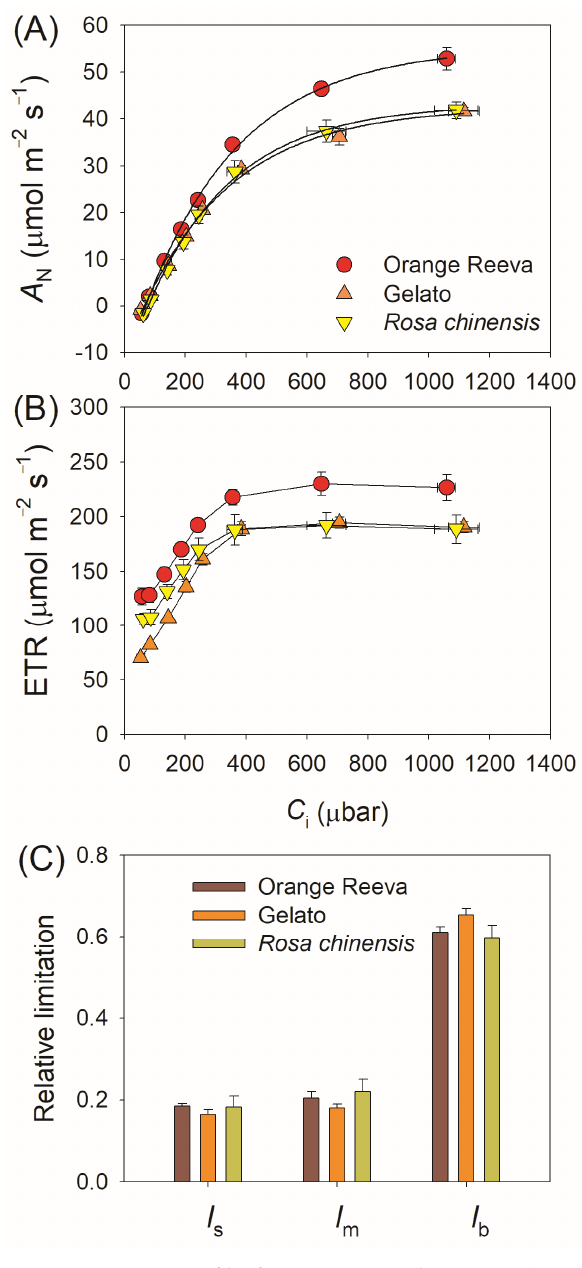
Figure 2. Response of leaf net CO 2 assimilation rate ( A N ; A ) and electron transport rate (ETR; B ) to intracellular CO 2 concentration in two modern rose cultivars (Orange Reeva and Gelato) and the old Chinese rose plant Rosa chinensis . ( C ) Quantitative analysis of relative limitation imposed on A N in these three rose genotypes. l s , stomatal conductance limitation, l m , mesophyll conductance limitation, and l b , biochemistry limitation. All A / C i curves were measured under a saturating light of 1500 µ mol photons m − 2 s − 1 . Data are means ± SE ( n =